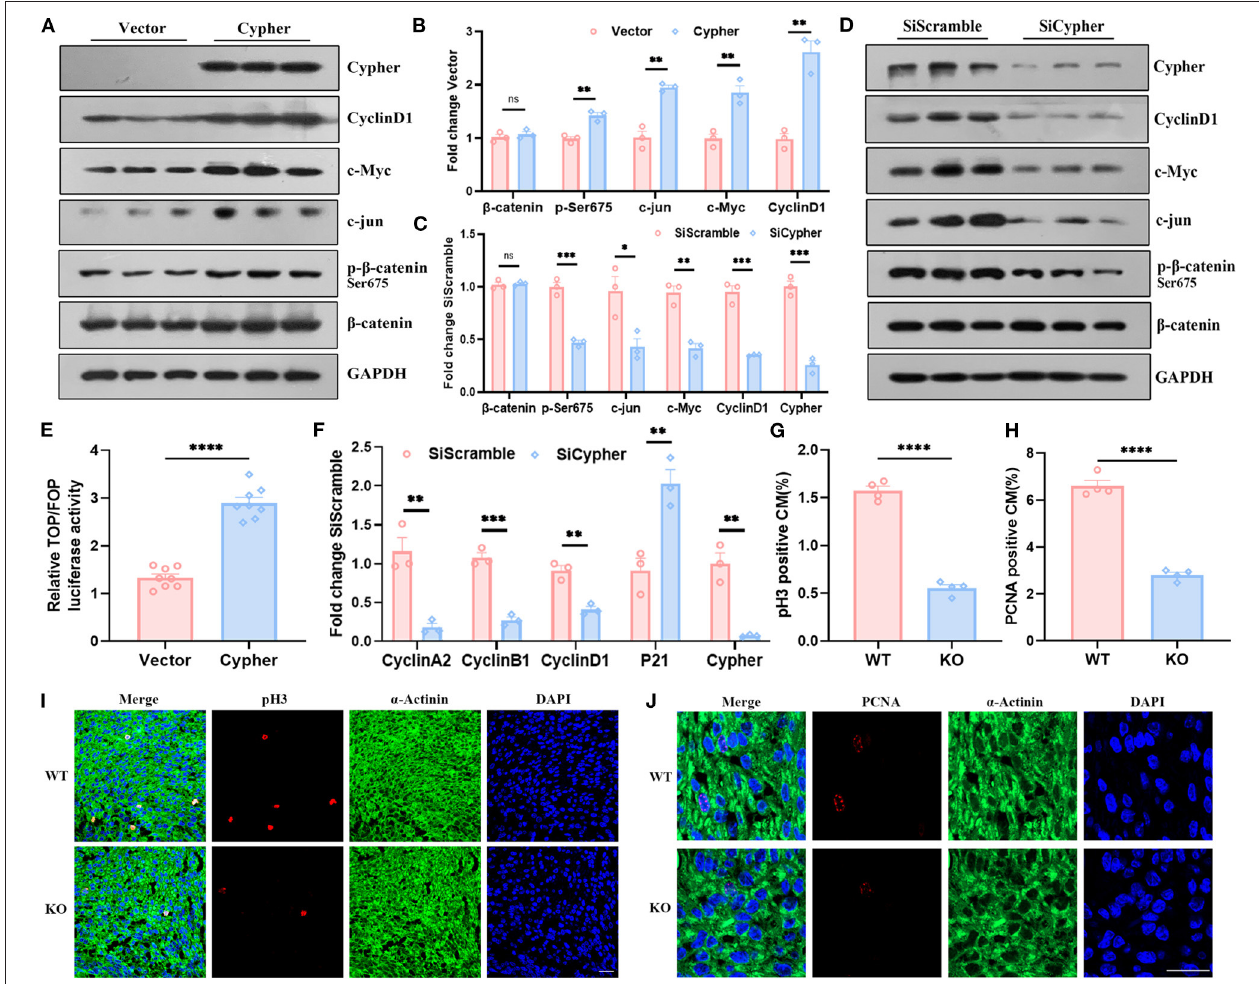
FIGURE 5 | Cypher activates β -catenin via Ser675 phosphorylation and modulates cardiomyocyte proliferation. (A,B) Myc-tagged Cypher was overexpressed in non-cardiac HEK293T cells with no endogenous Cypher. Empty vector served as a control. The expression of p- β -catenin, β -catenin and its target genes, including cyclin D1, c-Myc, and c-jun, were detected using western blotting and quantified. N = 3 biologically independent samples. (C,D) H9C2 cells with endogenous Cypher were transfected with scramble control (SiScramble) or Cypher siRNA (SiCypher). Cypher, p- β -catenin, and β -catenin and the abundance of its target genes were examined and quantified. N = 3 biologically independent samples. (E) Dual-luciferase reporter assays were performed to evaluate β -catenin transcriptional activity. HEK293T cells were cotransfected with Cypher or empty vector and TOP or FOP plasmid. The renilla plasmid was used as an internal control. N = 8 biologically independent samples. (F) The mRNA levels of the cell cycle-related genes (cyclin A2, cyclin B1, cyclin D1, and P21) were measured in Cypher-knockdown H9C2 cells using real-time quantitative polymerase chain reaction (RT-qPCR). N = 3 biologically independent samples. (G,I) Immunofluorescence staining of pH3 in the hearts of newborn (P0) WT and Cypher-KO mice. α -actinin + pH3 + labels proliferating cardiomyocytes. (G) Quantification of pH3-positive cardiomyocytes in the P0 hearts (6,379 cardiomyocytes in the WT group and 5,773 cardiomyocytes in the Cypher-KO group). N = 4 biologically independent samples. (H,J) Immunofluorescence staining of PCNA in the P0 WT and Cypher-KO hearts. α -actinin + PCNA + labels proliferating cardiomyocytes. (H) Quantification of PCNA-positive cardiomyocytes in the P0 hearts (4,518 cardiomyocytes in the WT group and 3,587 cardiomyocytes in the Cypher-KO group). N = 4 biologically independent samples. Scale bars: 25 µ m. *, p < 0.05; **, p < 0.01; ***, p < 0.001; ****, p < 0.0001; ns, no significant difference. Error bars indicate the mean ± SEM. Unpaired two-tailed Student’s t -test (B,C,E–H) was